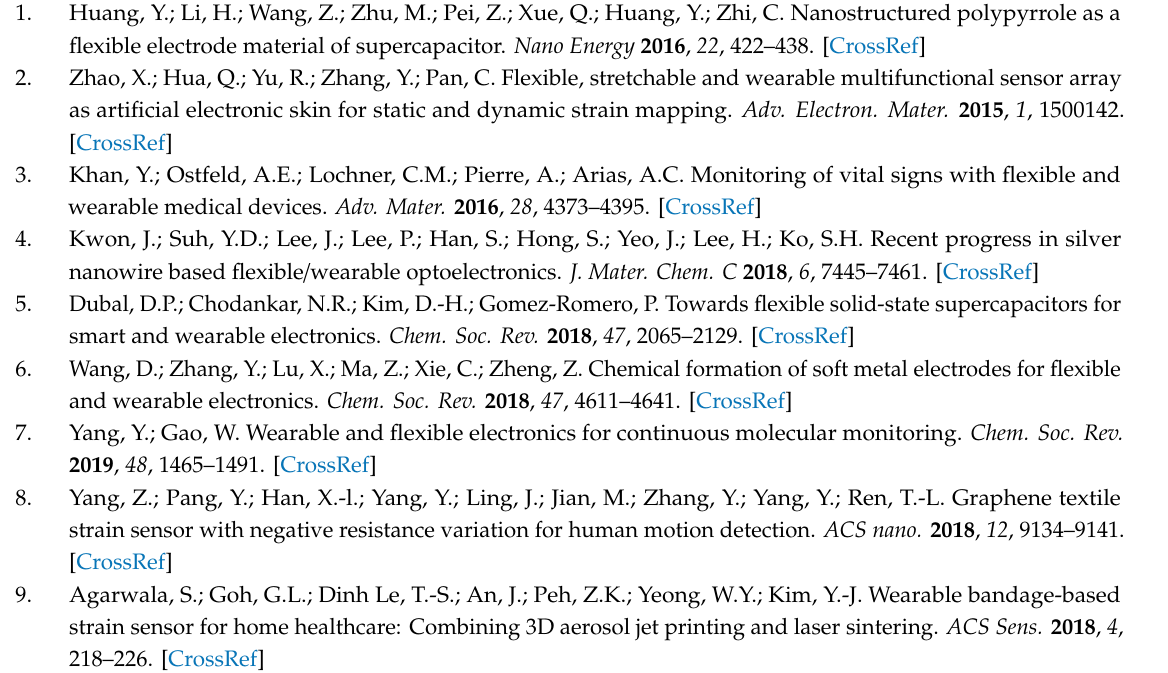
Figure S1: (a) SEM image of TPU membrane under dip-coating of graphene for 1 time; (b) high magnification of SEM image of TPU membrane under dip-coating of graphene for 6 times; (c) SEM image of TPU membrane under dip-coating of graphene for 6 times; (d) SEM image of a coil of the TPU / graphene strain sensor in the original state; (e) high magnification SEM image of a coil of the TPU / graphene strain sensor in the original state; (f) SEM image of a coil turn into flat of the TPU / graphene strain sensor under 800 strain. Figure S2: Conductivity under various dip-coating time. Table S1: Comparison of the gauge factor and strain range for di ff erent strain